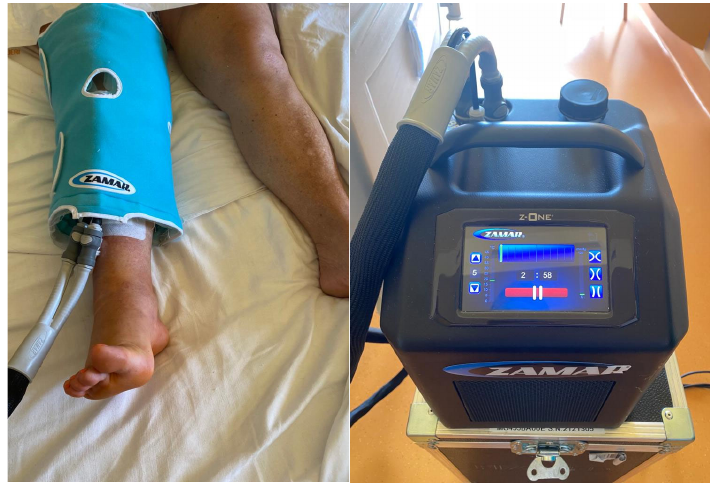
Figure 1. Application of cryotherapy pad on a patient.